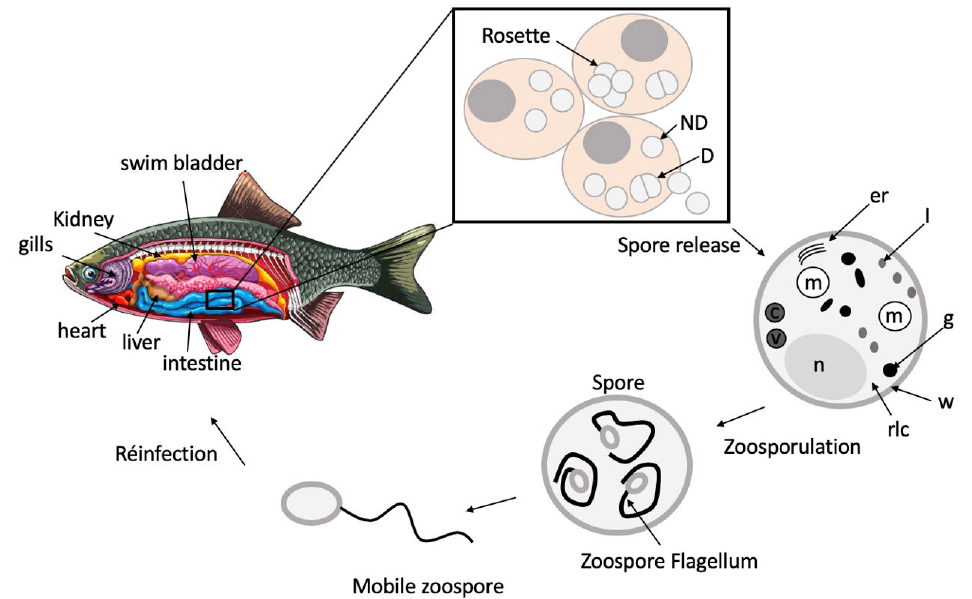
Figure 3. Life cycle, spore stages, and ultrastructure characteristics of RA. In infected fish, RA spores are observed in various organ tissues and cell hosts, including spleen, kidney, liver, intestine, heart, gills, and swimbladder, among others. Some of these are represented here. In fish tissues, RA spores are mainly intracellular and intracytoplasmic, although some spores are found extracellularly. Within infected host cells, single spores are present and various aggregates of apposed spores are also observed as rosette structures. Different spore stages are found, such as dividing (4–6 µ m in diameter) and non-dividing stages (2–4 µ m in diameter). Each spore can produce up to five daughter spores. Death of host cells allows for RA spores to be released into freshwater where they undergo zoosporulation via the uncoiling of a motile flagellum that comprises a body of approx. 2 µ m in diameter and a flagellum of approx. 10 µ m in length. RA spore ultrastructure; D: dividing spore